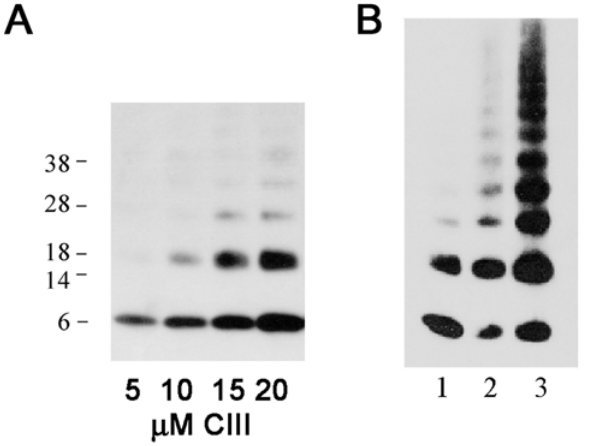
Figure 3. Oligomerization of CIII. ( A ) 10 m l of different concentrations of purified His 6 -CIII protein were loaded on 4–12% NuPAGE (invitrogen) and visualized by western blotting using commercial antibodies against the His6 tag. ( B ) 10 m M of His 6 -CIII was incubated in the presence (lanes 2,3) or absence (lane 1) of 0.25% Glutaraldehyde and the cross-linking reaction was stopped after 1 or 5 minutes by 200 mM Glycine (lanes 2 and 3 respectively). The reactions were loaded on 4–12% NuPAGE (invitrogen) and visualized by western blotting using commercial antibodies against the His6 tag.